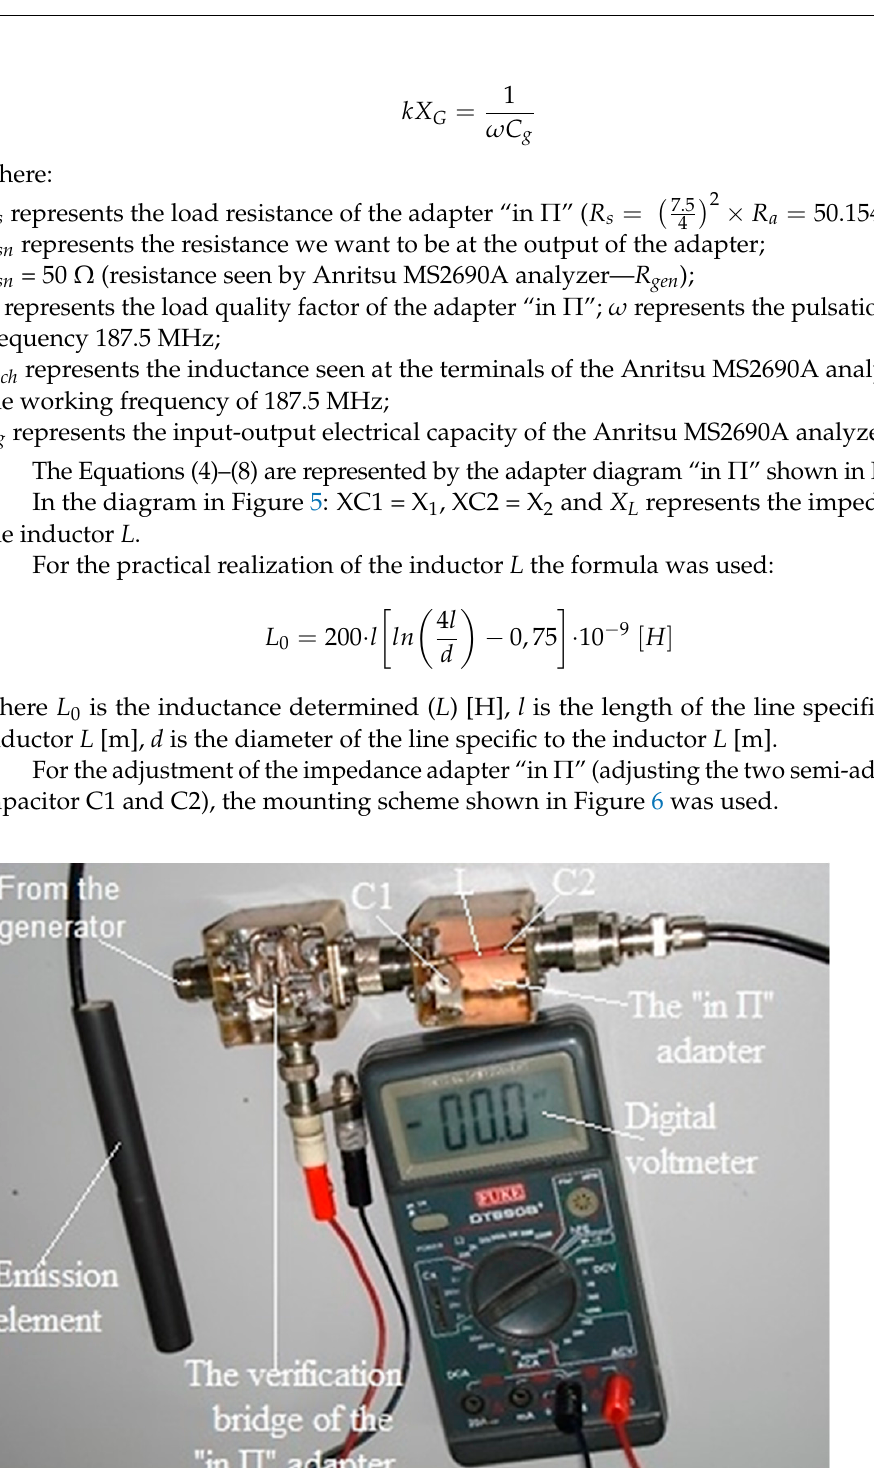
Figure 5. Electrical diagram of the adapter “in Π ”.